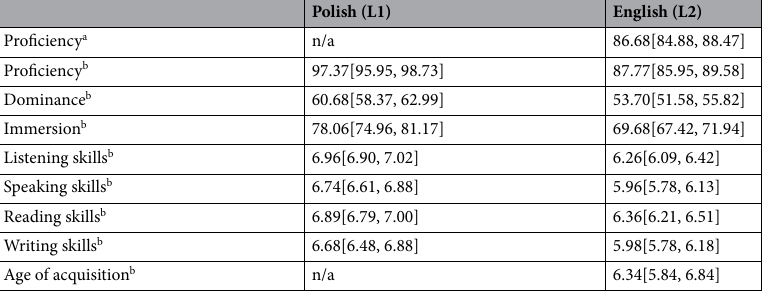
Table 1. Participants’ sociolinguistic data (means with 95% CI). a LexTALE 72 (percentages); b Language History Questionnaire 3.0 45 (as translated into Polish by Naranowicz & Witczak): the proficiency, dominance, and immersion scores (percentages); listening, speaking, reading, and writing skills (1—very low proficiency, 7— very high proficiency); age of acquisition